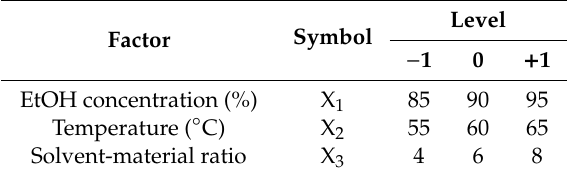
Table 1. Experimental factors with their levels used in the experiment.